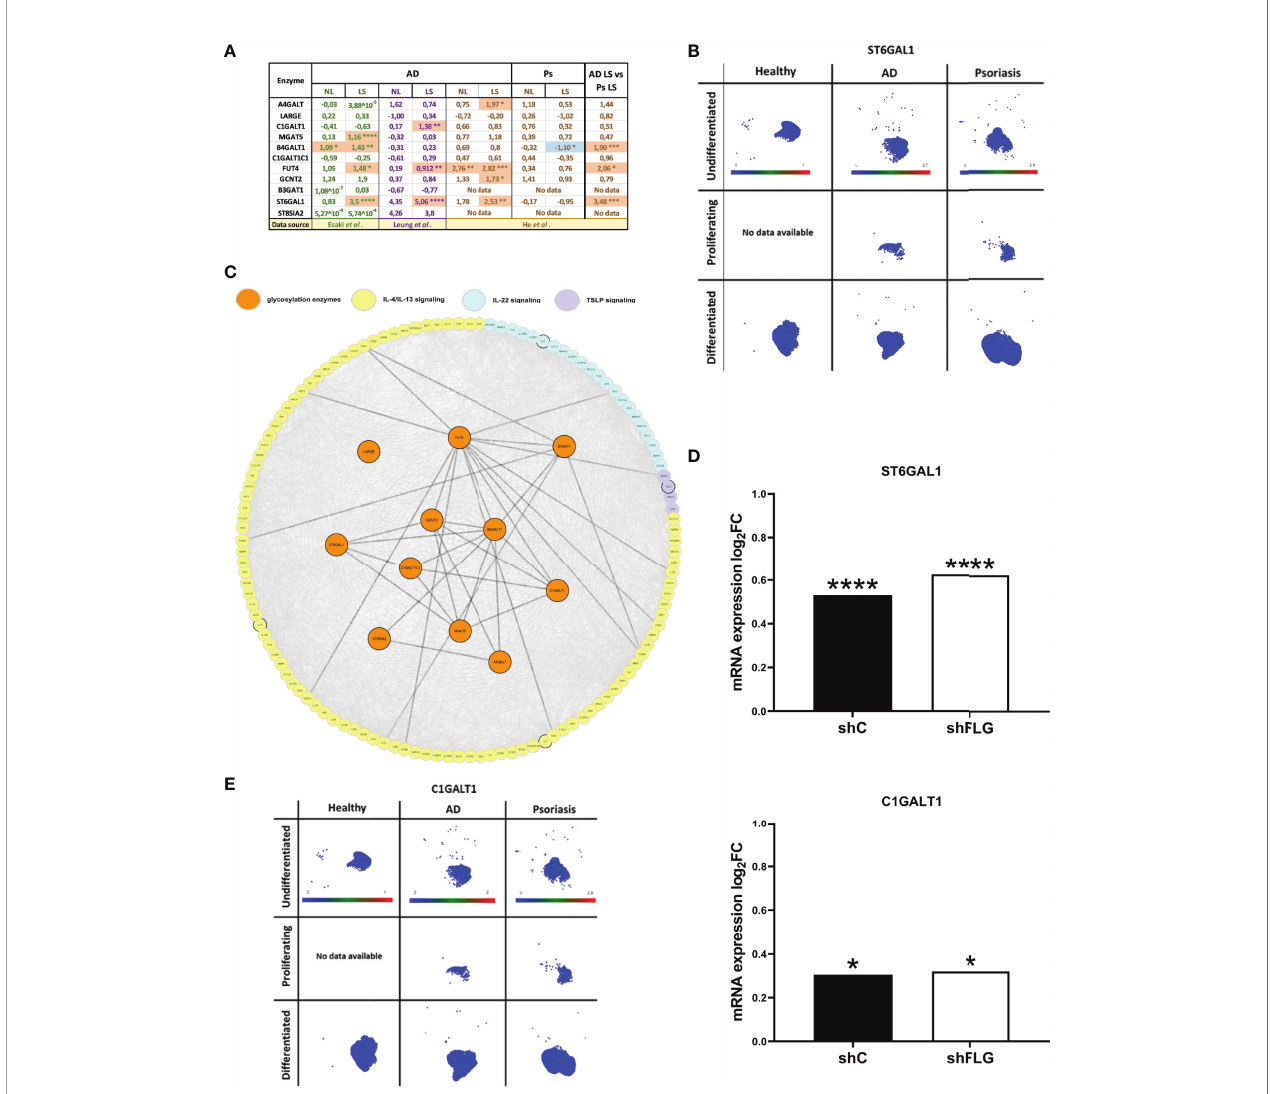
FIGURE 4 | Glycosylation enzymes are upregulated in the epidermis of AD patients and keratinocytes exposed to AD milieu. (A) The expression of glycosylation enzymes in the epidermis of AD and Ps patients; analysis of the transcriptome pro fi ling data available as datasets in Esaki et al., Leung et al. and He et al. (values in the table show expression log 2 FC compared to healthy epidermis); *p < 0.05; **p < 0.01; ***p < 0.001; ****p < 0.0001; (moderated t-test for Esaki et al. and He et al., multiple unpaired t-tests for Leung et al.); NL, non-lesional epidermis; LS, lesional epidermis; (B) UMAP plots of single cell expression of ST6GAL1 enzyme in keratinocyte subpopulations in the skin; data available through Human Developmental Cell Atlas; (C) protein network links between AD-relevant cytokine pathways and the previously identi fi ed 11 glycosylation-relevant enzymes; (D) mRNA expression of glycosylation enzymes differentially regulated upon exposure to IL-4/IL-13 stimulation in fi laggrin-insuf fi cient (shFLG; knockdown) keratinocytes and control (shC) keratinocytes (log2 fold change shown); combined data for n=3 biological replicates; *p < 0.05; ****p < 0.0001 (moderated t-test); (E) UMAP plots of single cell expression of C1GALT1 enzyme in keratinocyte subpopulations in the skin; data available through Human Developmental Cell Atlas; ST6GAL1, b -Galactoside a -2,6-Sialyltransferase 1; C1GALT1, Core 1 b ,3-Galactosyltransferase carbohydratemoietiesbylectinarray.Lectinarrayisausefultoolfor glycosylationpatternidenti fi cation;lectinsontheslidehavebinding speci fi city towards de fi ned carbohydrate moieties which allows